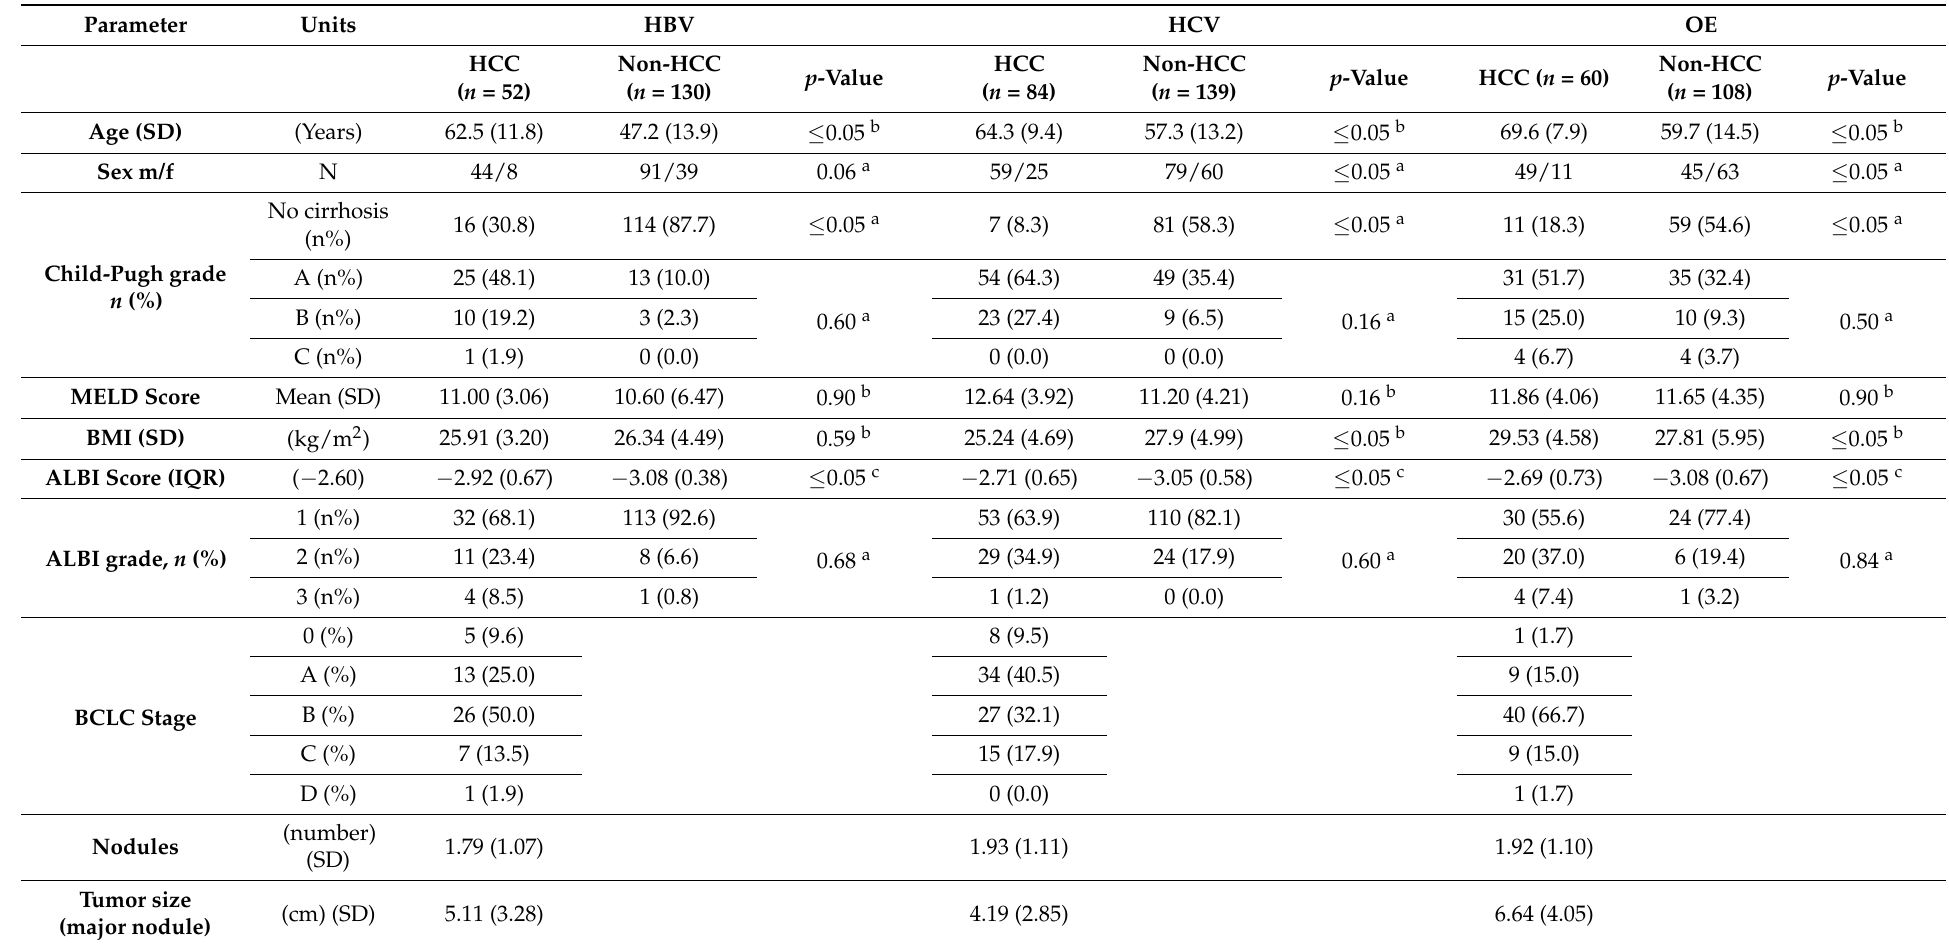
Table 1. Demographics, Characteristics of HCC and non-HCC-Group for HBV, HCV and